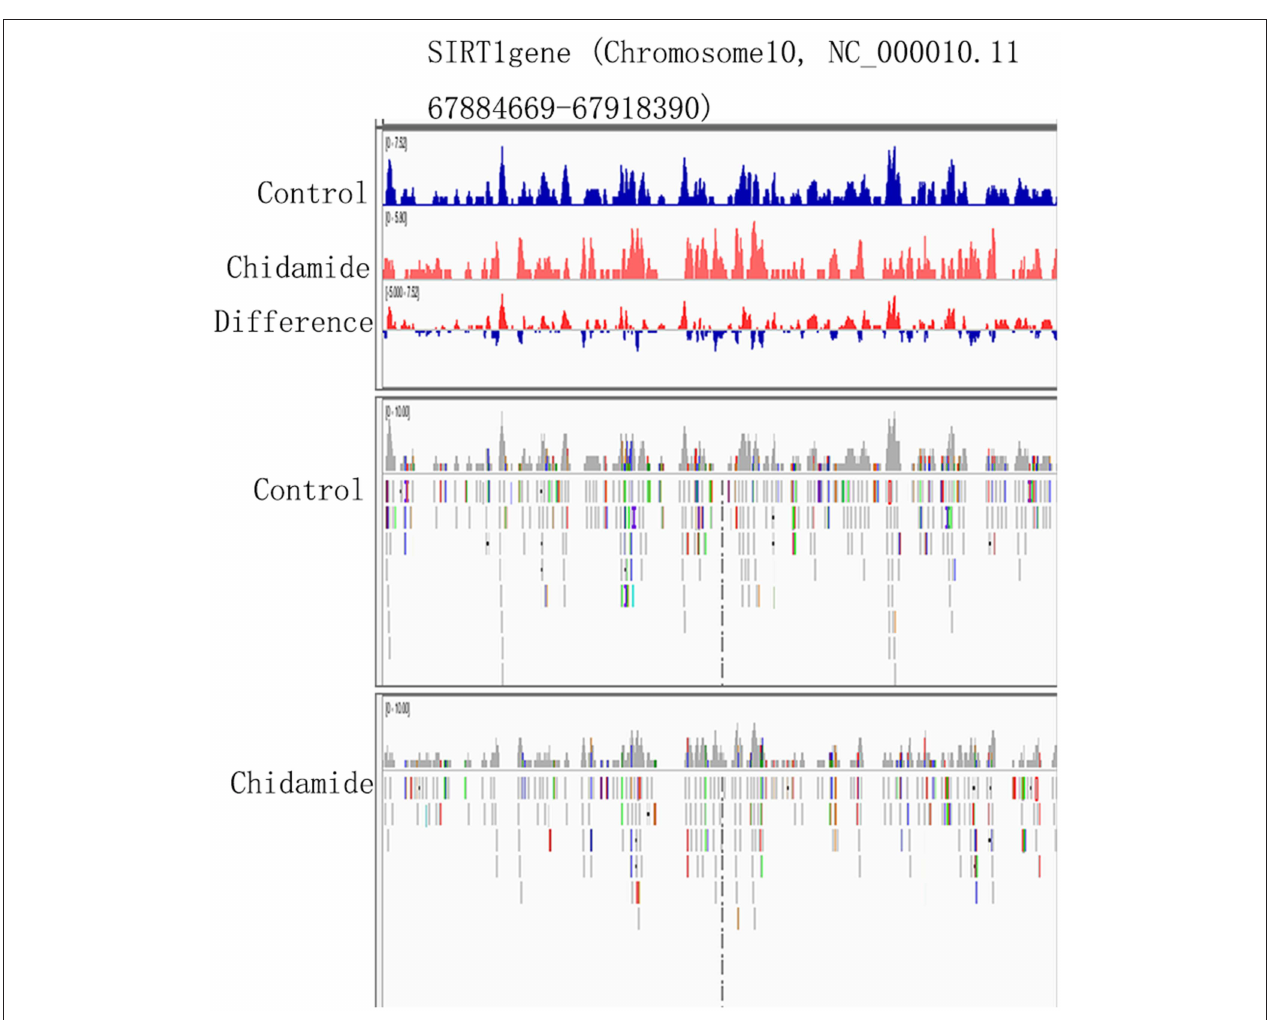
FIGURE 6 | The potential change in H3K9me3-binding sites on SIRT1. The IGV heatmap mode showing the expression level at the same binding site for chidamide-treated acute myeloid leukemia cells and control group cells. The Integrative Genomics Viewer tracking data are also shown.